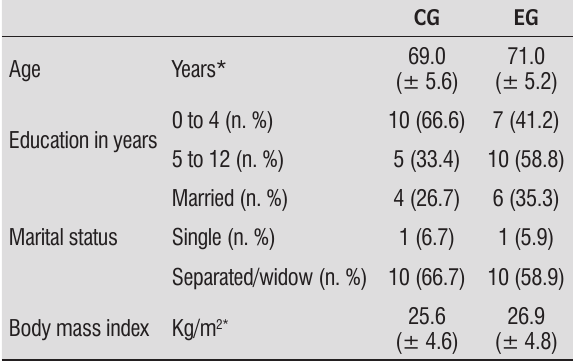
Table 1 - Distribution of the frequencies of individuals according to sociodemographic characteristics.